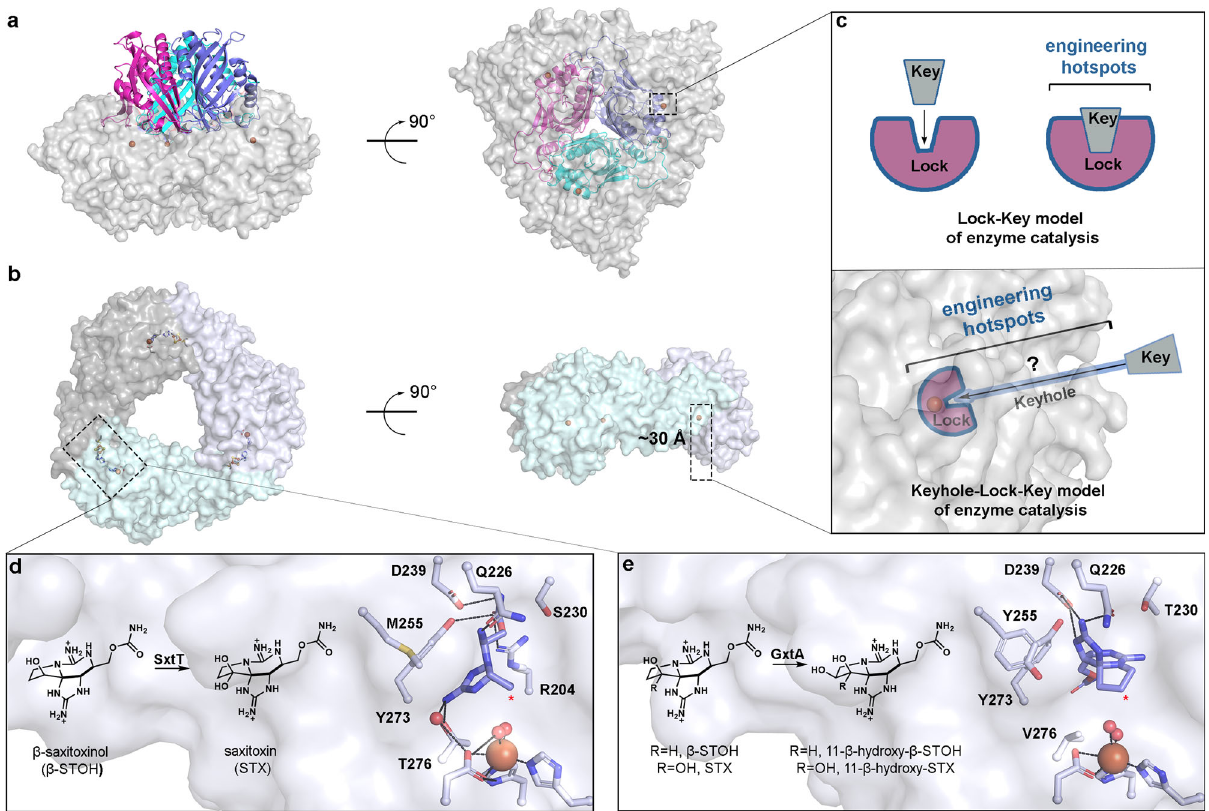
Fig. 1 Rieske oxygenases adopt a trimeric architecture that sequesters the metal-based active site and reactive pathway intermediates in the interior of the protein. a The quaternary architecture of an α 3 β 3 Rieske oxygenase that is observed primarily in Rieske oxygenases that catalyze cis -dihydroxylation reactions 15 – 23 . This panel is shown in two orientations that differ by a 90° rotation (PDB: 1NDO 22 ). Here, the three catalytic α -subunits are shown in gray and the β -subunits are shown in pink, cyan, and purple. b The quaternary architecture of a homotrimeric α 3 Rieske oxygenase is observed in 10 of the 18 available non-redundant Rieske oxygenase crystal structures 7 – 14 (PDB: 6WN3 7 ). The active site of the α 3 Rieske oxygenases is also buried deep within the protein core. c The architecture of α 3 β 3 and α 3 Rieske oxygenases require the substrate to travel to reach the active site before catalysis can occur. The extra architectural region that the substrate must traverse is known as the “ keyhole ” and unlike the traditional Lock-Key model of enzyme catalysis, requires the substrate to interact with protein regions outside of the active site 36 . The identity and importance of these auxiliary “ keyhole ” regions and their relationship to the selectivity of a Rieske oxygenase catalyzed reaction is yet to be determined. d SxtT catalyzes the conversion β -saxitoxinol ( β -STOH) to saxitoxin (STX) and e GxtA catalyzes the conversion of β -STOH and STX to 11- β -hydroxy- β -saxitoxinol and 11- β -hydroxysaxitoxin, respectively 42 . The selectivity exhibited by SxtT and GxtA can be partially attributed to two active site residues that position the substrate correctly for hydroxylation at the respective positions (marked with a red asterisk) 7